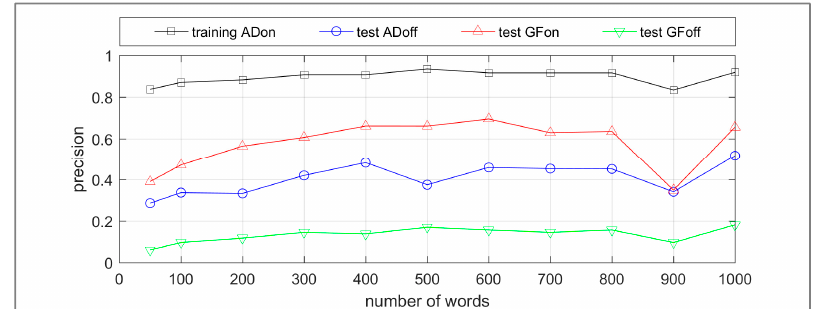
Figure 12. Precision of the SVM classifier for the WA OTG class when trained with images of the ADon dataset and tested on images of the ADoff, GFon and GFoff datasets against vocabulary size.